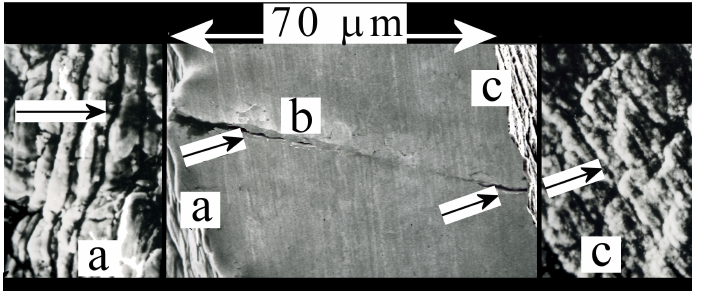
Figure 7. View of cracks, (a): cracks near blocking entry surface facing to electrolyte; (b): cracks crossing right through thickness of palladium; (c): cracks near blocking exit surface, arrow showing cracks, arrow showing direction of penetration for hydrogen—scaling is indicated in the